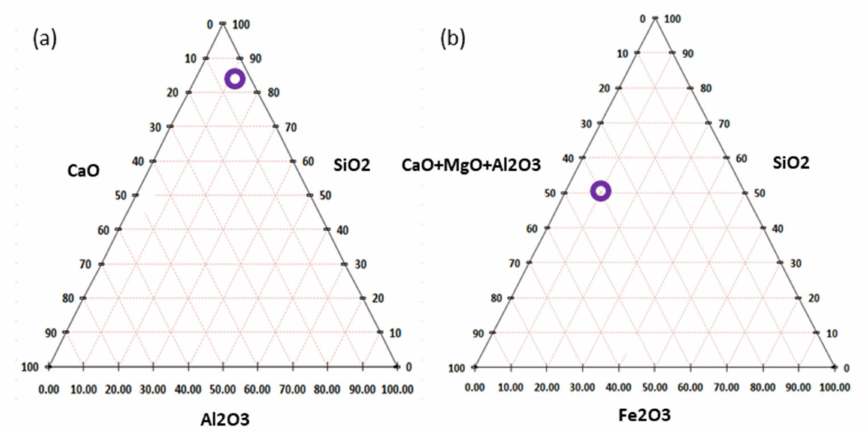
Figure 6. Ternary diagrams of kimberlite’s elemental composition (circles). ( a ) SiO 2 , CaO, and Al 2 O 3